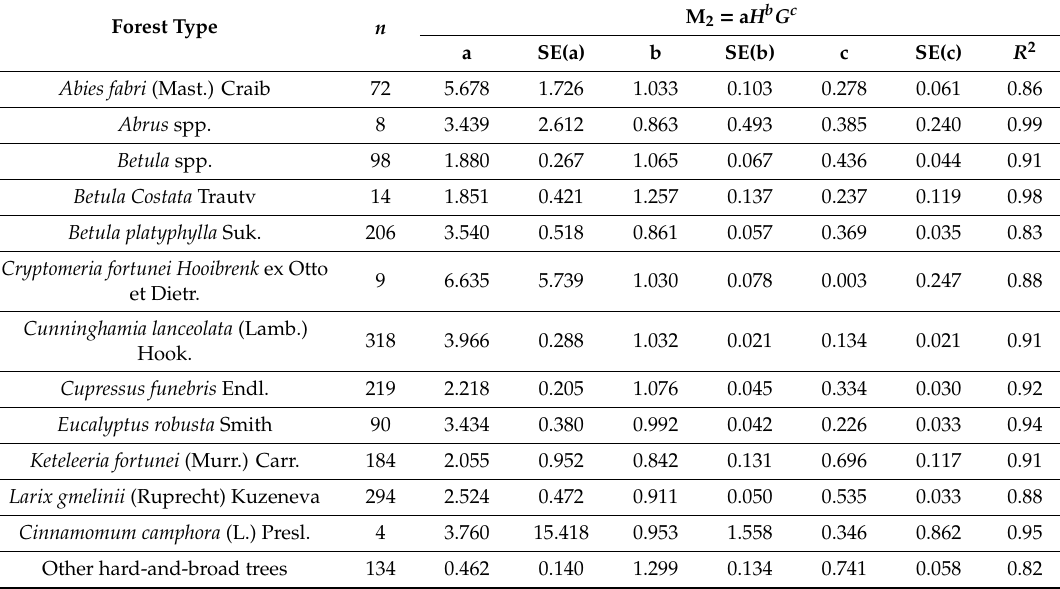
Table 5. Fitting results for model